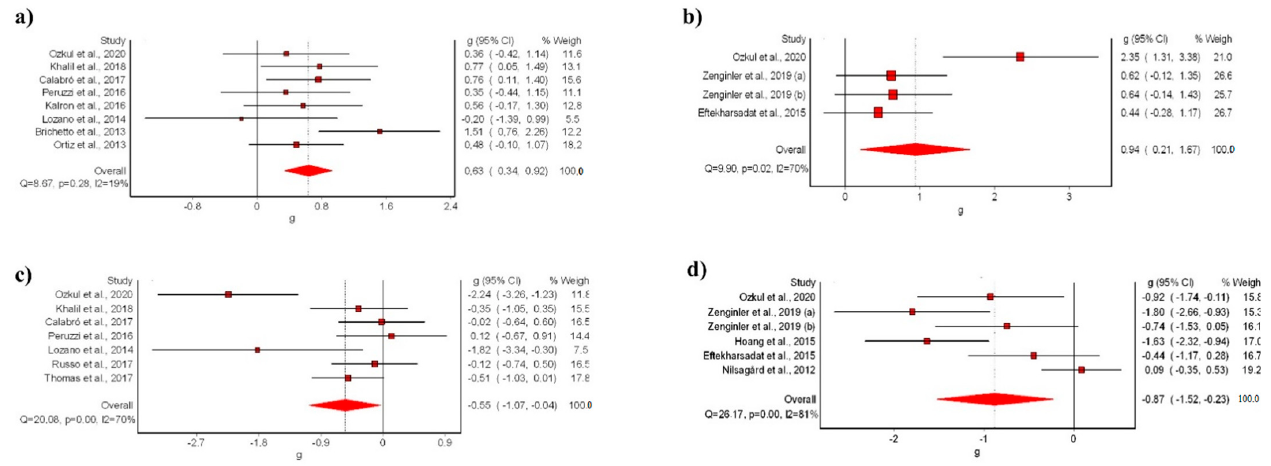
Figure 3. Synthesis forest plot of: ( a ) BSS variable (VR vs. conventional treatment); ( b ) BSS variable (VR vs. no-treatment); ( c ) TUG variable (VR vs. conventional treatment); ( d ) TUG variable (VR vs. no-treatment). The forest plot summarizes the results of the included studies (sample size, standardized mean differences (SMDs), and weight). The small boxes with the squares represent the point estimate of the effect size and sample size. The lines on either side of the box represent a 95% confidence interval (CI) [9,39,40,41,42,43,44,45,46,47,48,49,50,51,52,53]. Table 3. Certainty of